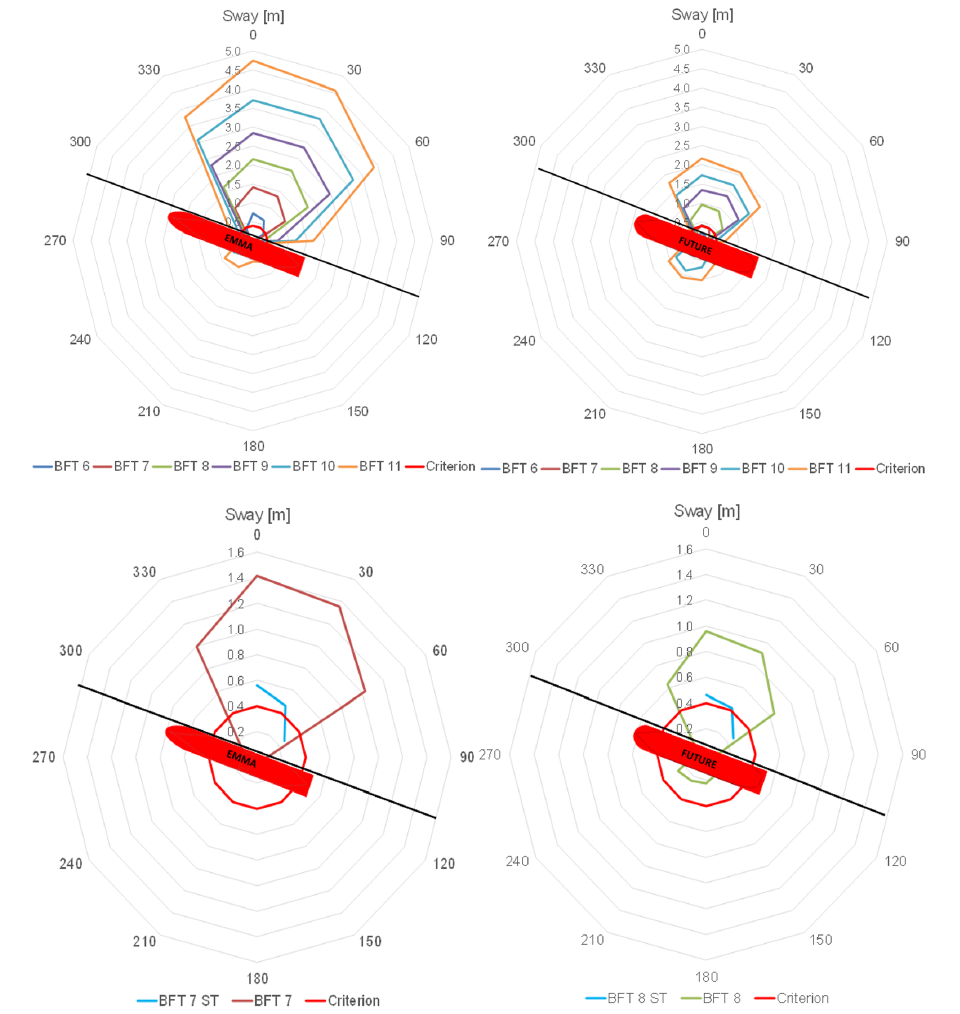
Figure 9. Significant sway motion results for dynamic wind conditions with and without ShoreTension ®